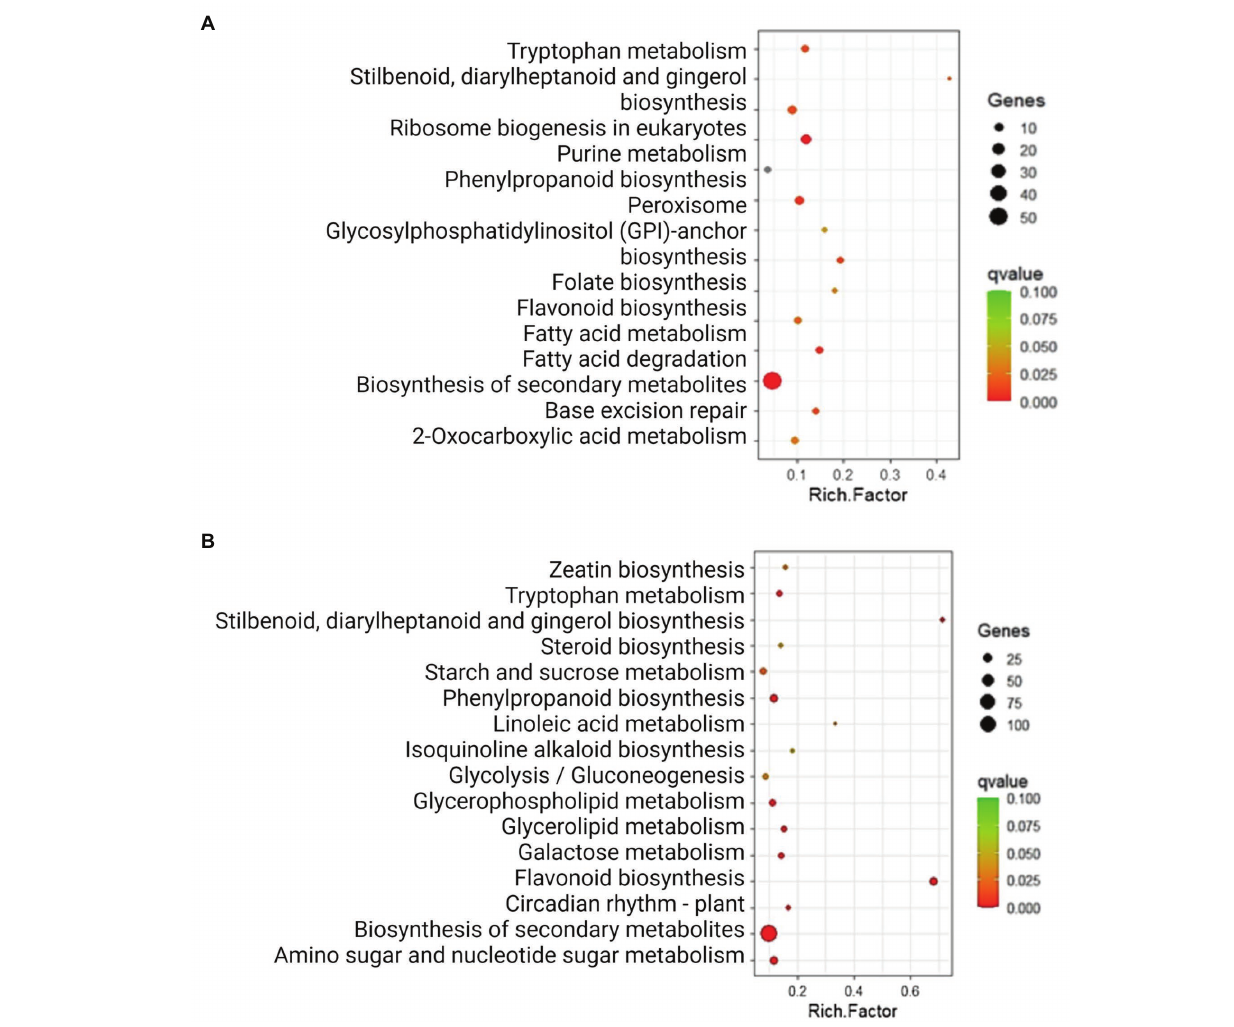
FIGURE 2 | Significantly enriched ( q < 0.05) KEGG pathways among the DEGs exclusively upregulated (A) and downregulated (B) in resistant genotype QL3. Rich factor is the ratio of the number of DEGs to the total gene number in a pathway. Here, the q -value is a corrected p -value. The color and size of the dots represent the range of q -value, and the number of DEGs mapped to the indicated pathways,